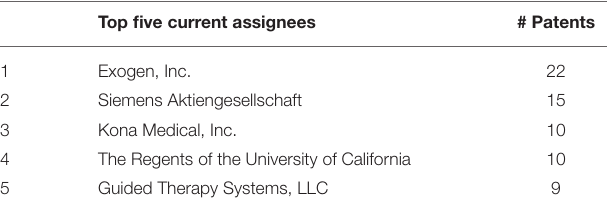
TABLE 7 | Top current assignees in the ultrasound energy-based therapeutic